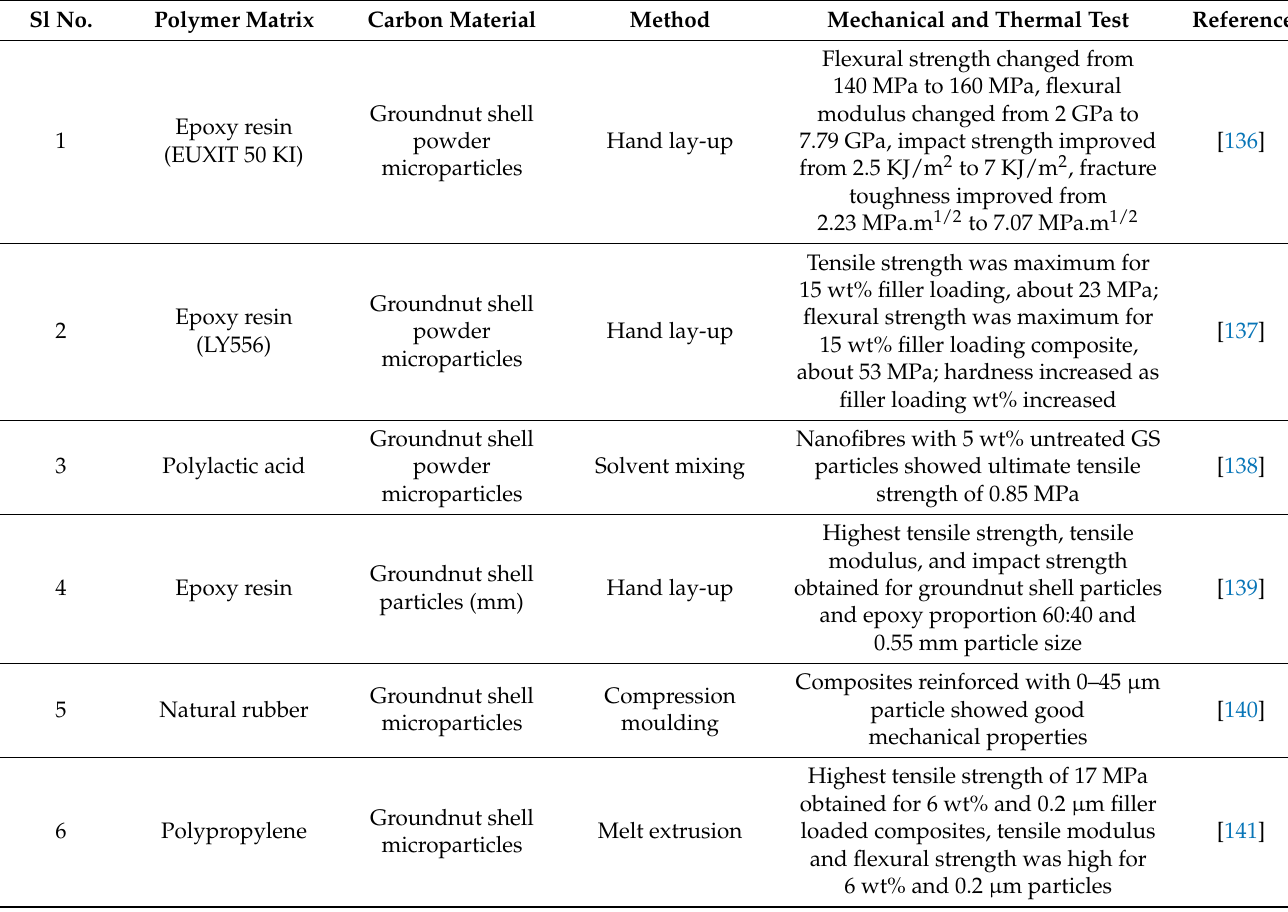
Table 13. Synthesis and characterization of groundnut shell